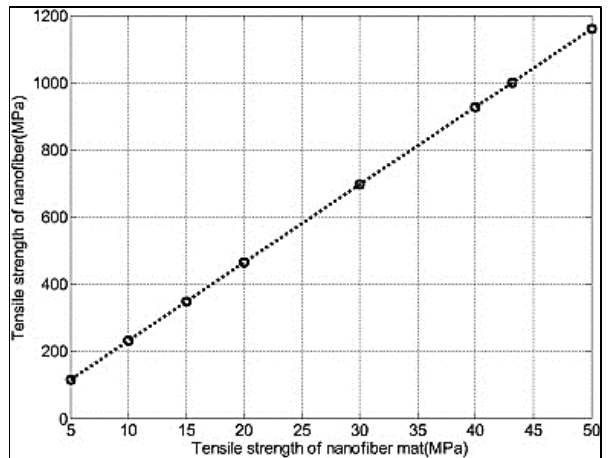
Figure 11. Stress–strain curve of carbon nanofiber mats [1].